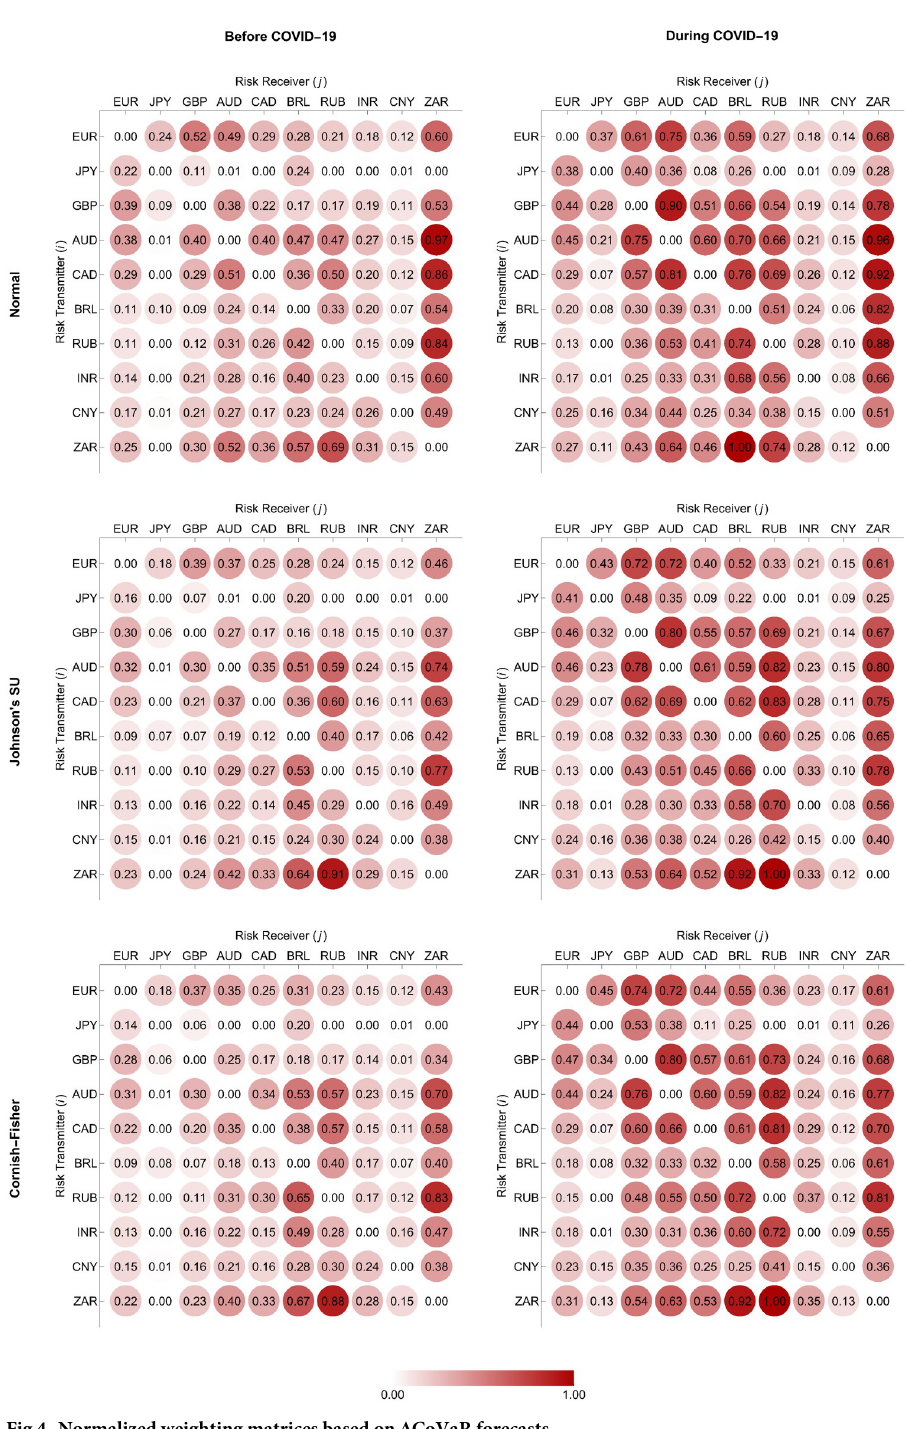
Fig 4. Normalized weighting matrices based on Δ CoVaR forecasts.